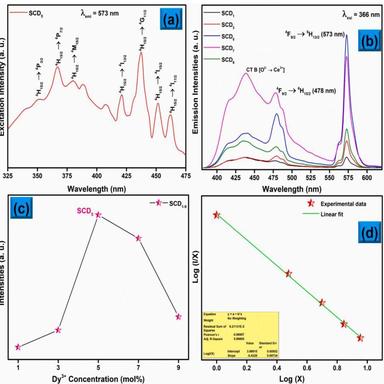
(a) excitation spectrum of SCD5 NPs at λemi = 576 nm, (b) emission spectra of SCD1-5 at λexi = 386 nm, (c) emission intensity v/s concentration of SCD1-9, and (d) dexter plot of SCD1-9.